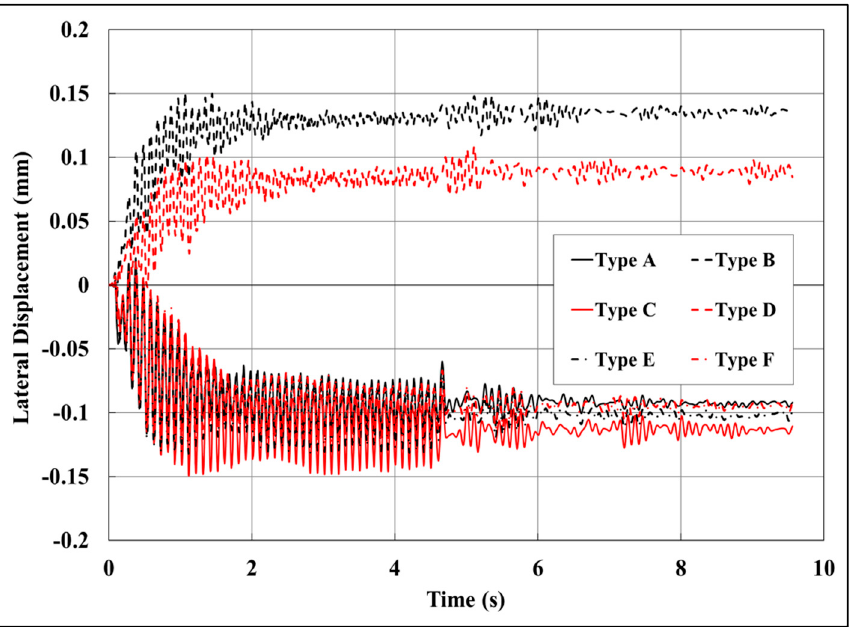
Figure 9. Lateral displacement at the bottom for each type: D-F2-B2-10 (type A), S-F1-10 (type B), D-F4-B4-5 (type C), S-F2-5 (type D), D-F4-B2-7.5 (type E), and D-F2-B4-7.5 (type F).